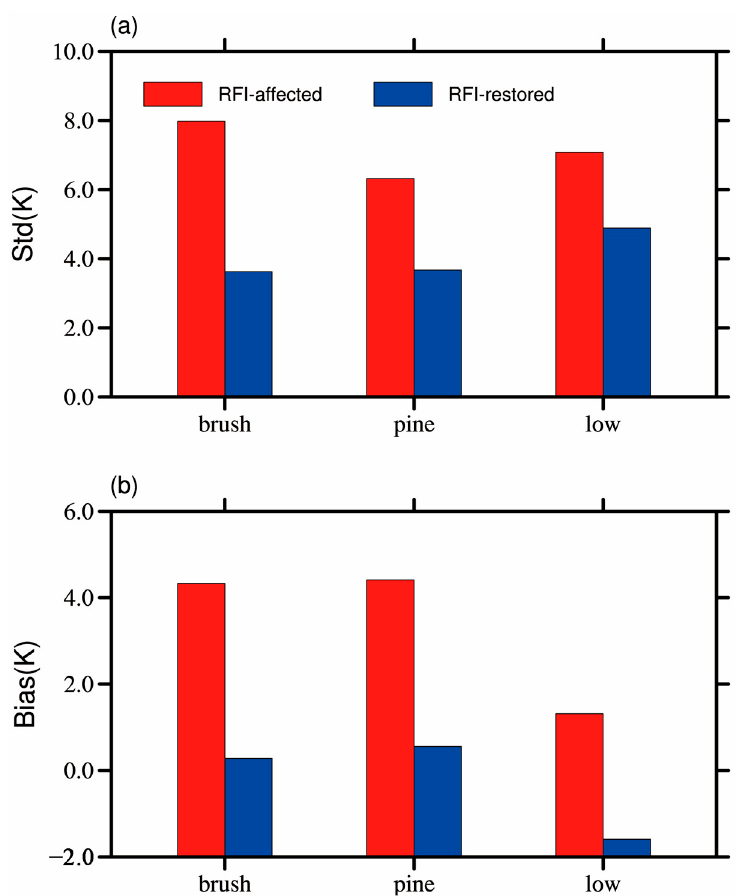
Figure 10. Comparison of standard deviation ( a ) and mean values ( b ) of OMB before (red bar) and after (blue bar) the restoration of RFI-affected data for the AMSR-2 6.9-GHz-V channel in 2016 over brush, pine forest, and low vegetation within the selected domain.